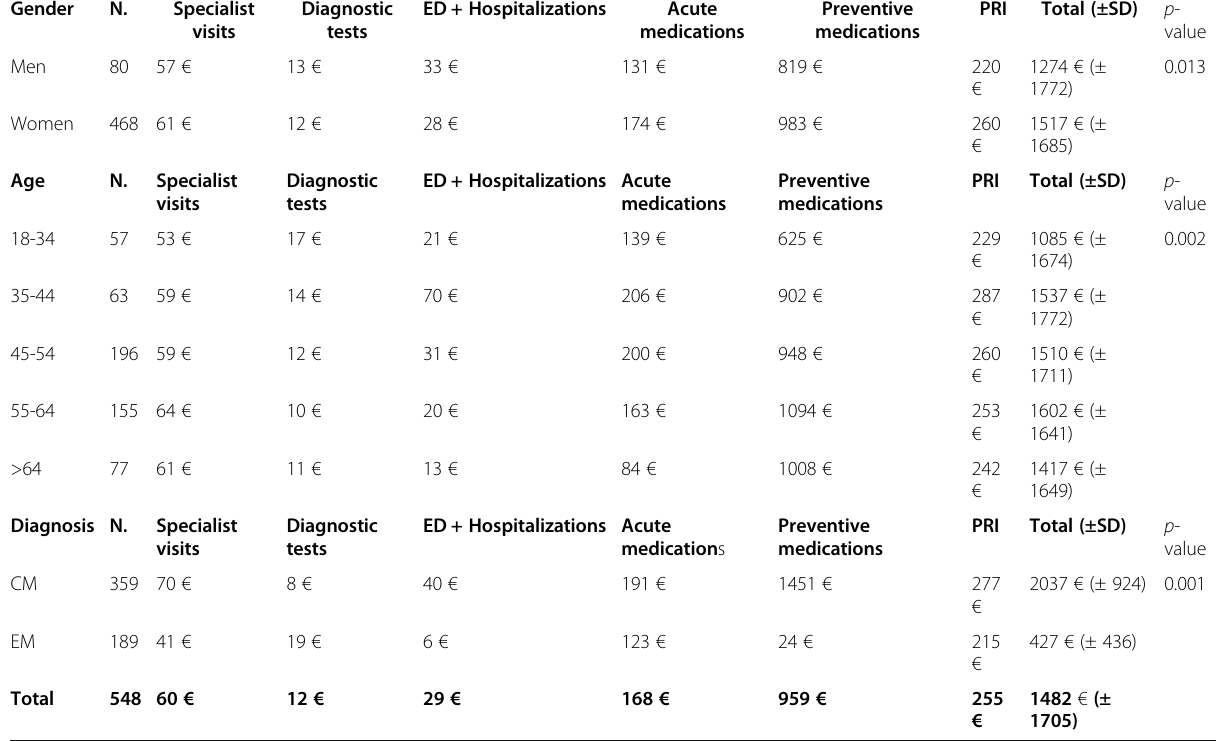
Table 7 Total annual direct cost per patient by gender, age and migraine status Gender